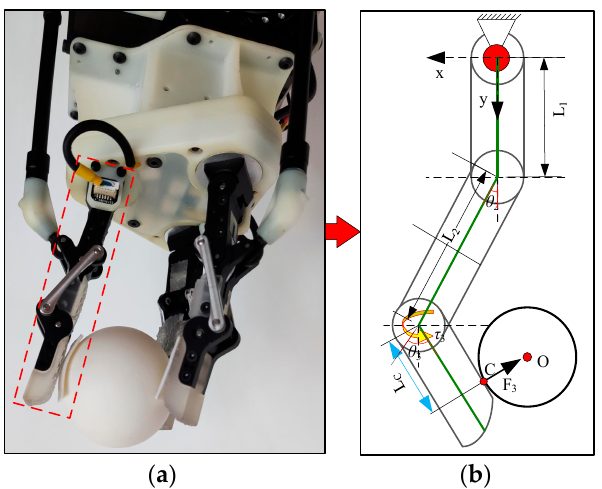
Figure 8. Geometric model of grasping of the distal phalanx of the fingers. ( a ) Physical picture. ( b ) Structure diagram.